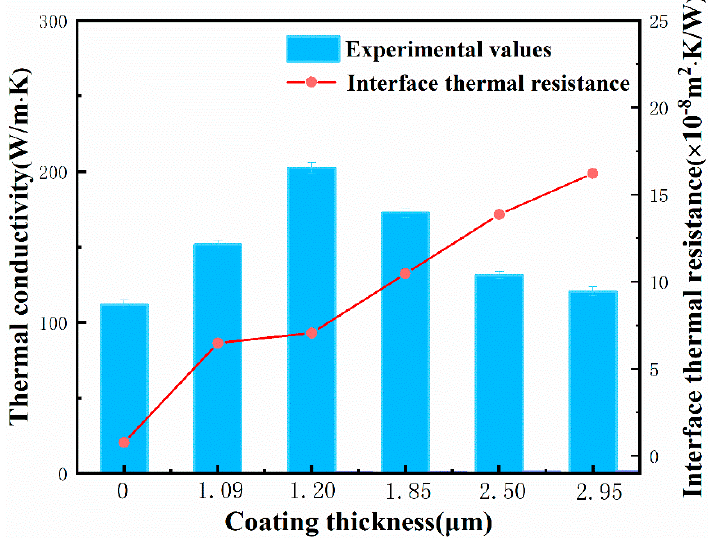
Figure 6. Thermal conductivity and interface thermal resistance of Mg/diamond (Cr) composites with different thicknesses of carbides.